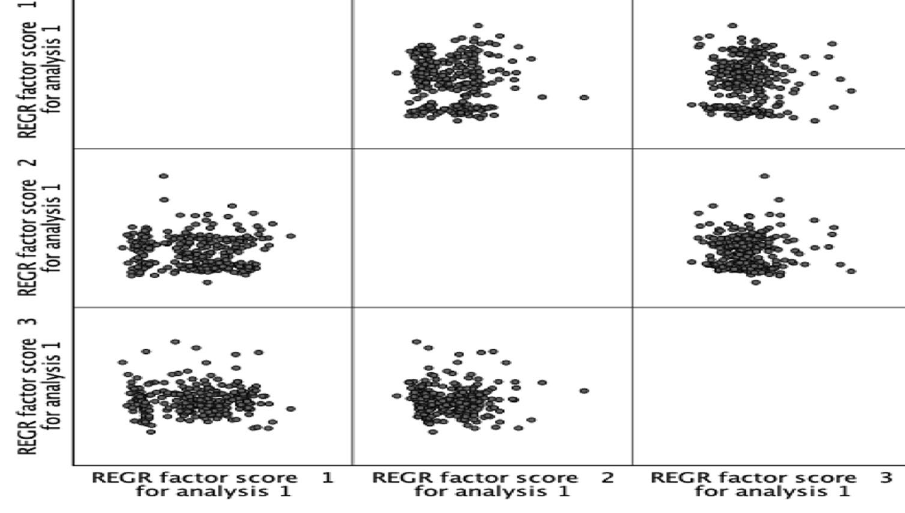
Fig. 4 Two-dimensional plots of scores of the first three factors are estimated by the regression